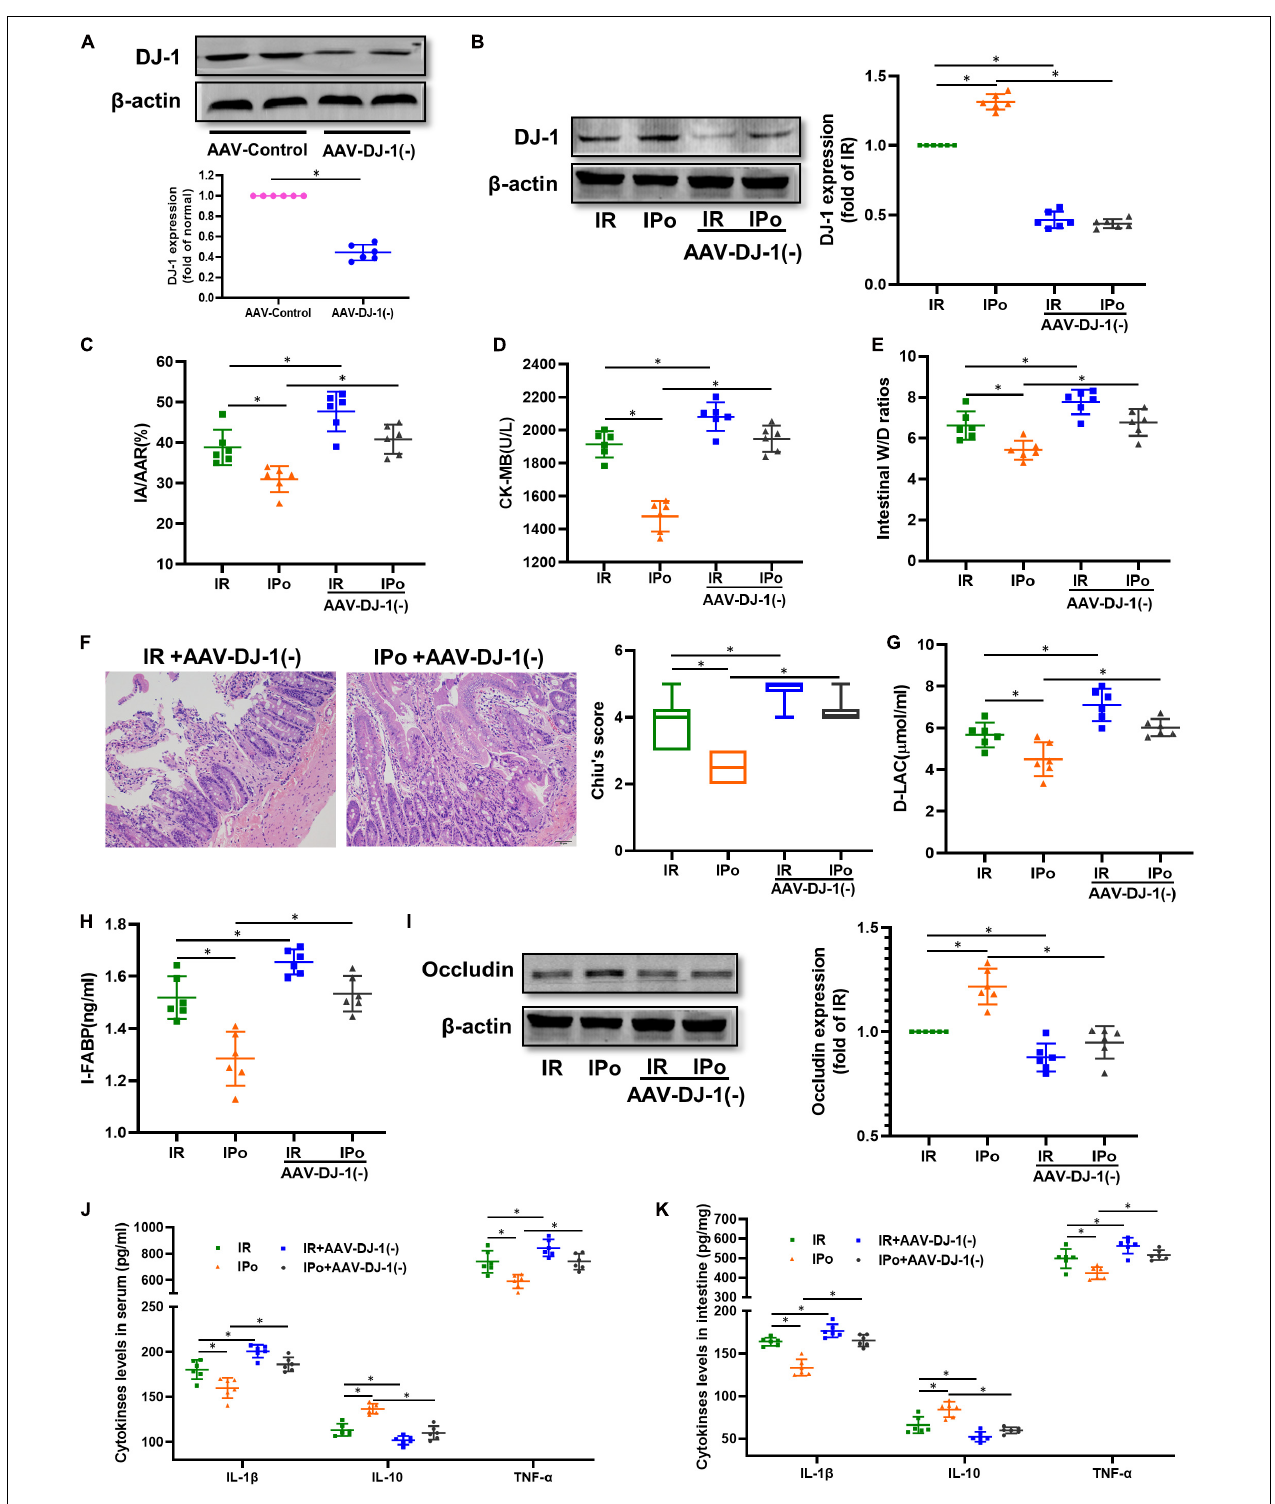
FIGURE 7 | Knockdown of DJ-1 abolished IPo induced protection against myocardial IR-induced intestinal injury. (A,B) Expression of DJ-1 level. (C) Infarct area relative to the area at risk (IA/AAR × 100%). (D) serum CK-MB level. (E) Intestinal water W/D ratios. (F) Histopathologic changes of the small-intestinal mucosa under light microscopy imaging (H&E staining, Scale bar = 300 µ m). Intestinal mucosa injury was graded by Chiu’s score. Serum concentrations of D-LA (G) and I-FABP (H) . (I) Expression of occludin. The levels of inflammatory cytokines (IL-1 β , IL-10, and TNF- α ) in the serum (J) and intestine (K) . β -actin was detected as loading control. S, Sham; IR, ischemia reperfusion; IPo, ischemic postconditioning. Data are mean ± SD or Box-Whisker’s plot ( n = 6); * P < 0.05.